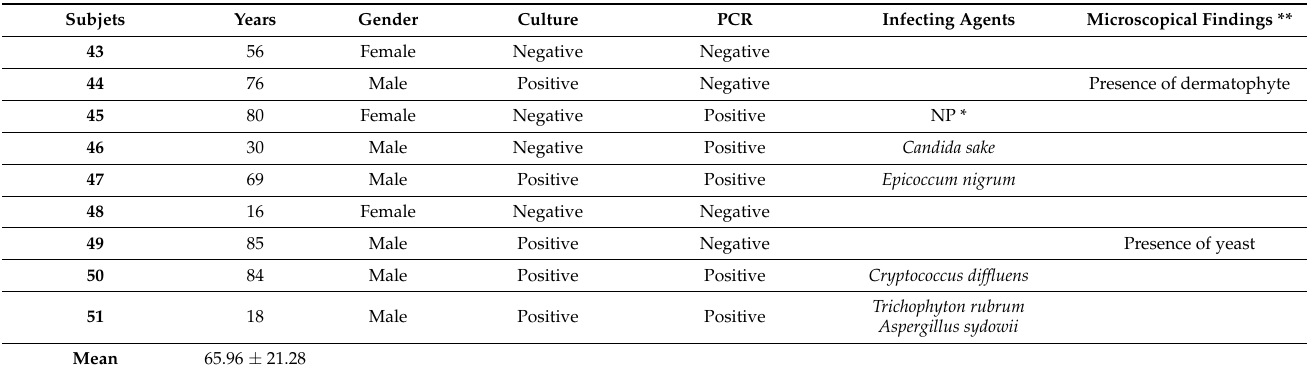
* NP—It was not possible to sequence the genetic material to determine the infecting agent. ** Fluorescence microscopy as described under Materials and Methods.